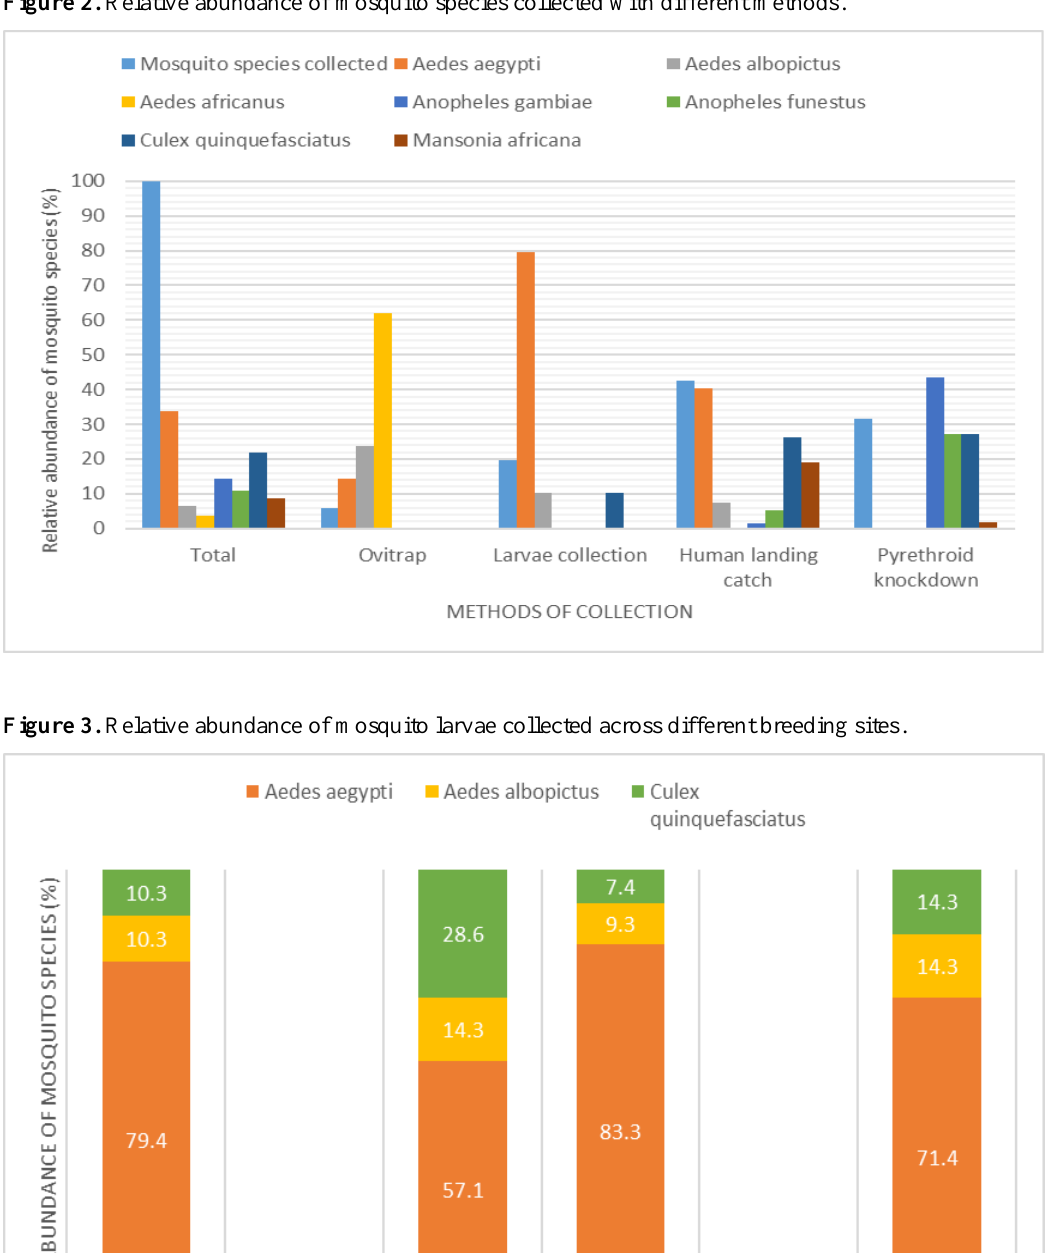
Figure 2. Relative abundance of mosquito species collected with different methods.